Question: Does the plotted quantity increase or decrease?
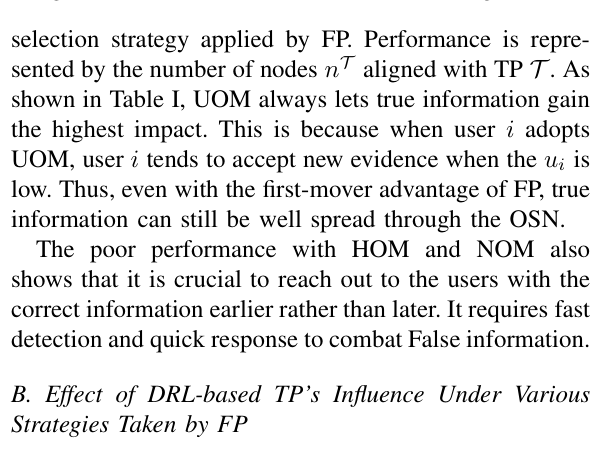
Answer: increasing